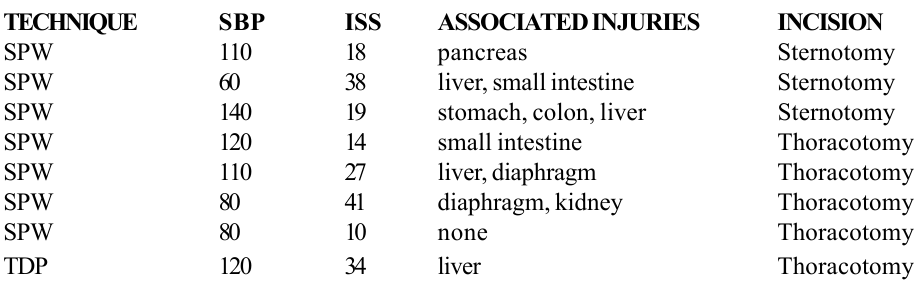
TABLE 3 - SPW and TDP false positive results.